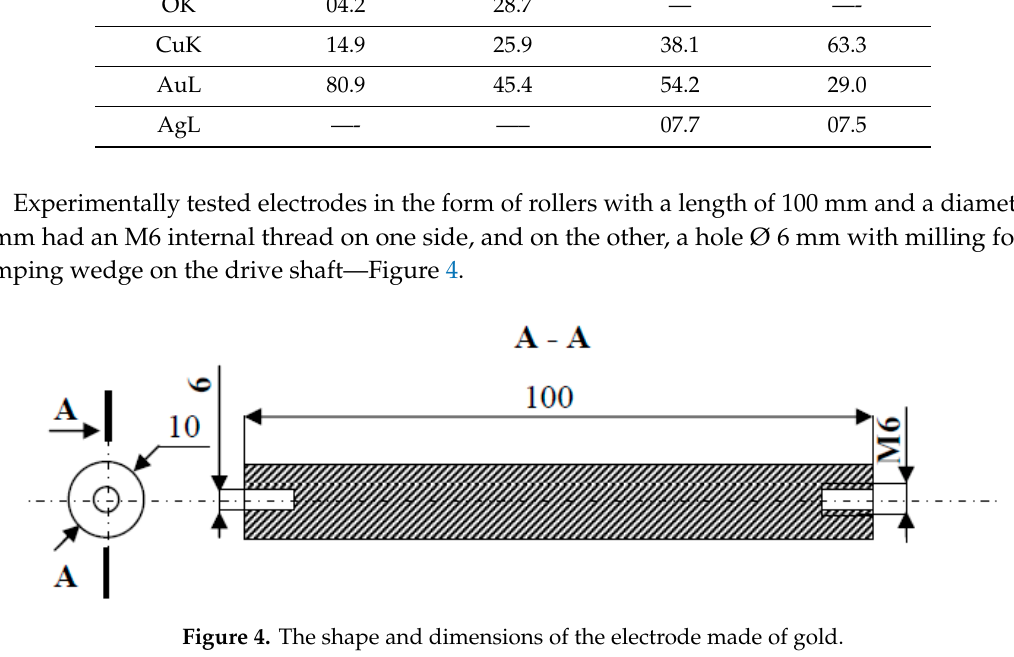
Table 1. Results of microanalysis of the chemical composition of the coating layer on a copper electrode with electrolytically-deposited gold. Place of Measurement Element